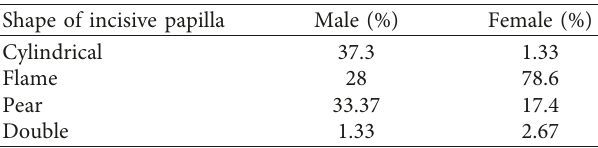
Table 4: The percentages of different shapes of incisive papilla in Jordanian